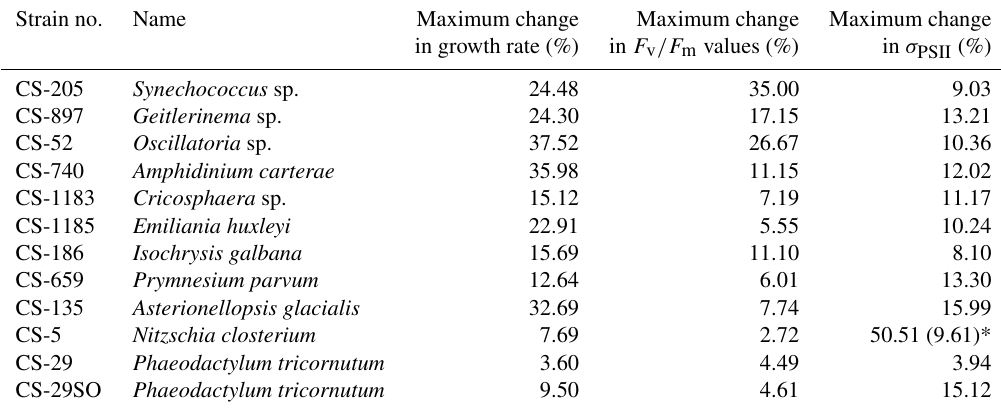
Table A3. The maximum change in growth rate, F v /F m , and σ PSII values. The change in each treatment from each species was calculated as follows: | V − V ave | /V ave × 100%, where V are treatment specific measurements, and V ave is the average value in all 17 treatments. The maximum change is the largest change between an individual treatment and the treatment average. In species N. closterium (CS-5), the highest σ PSII value was 51% higher than the average values, and this could be an outlier as the second highest change in N. closterium (CS-5) σ PSII values was